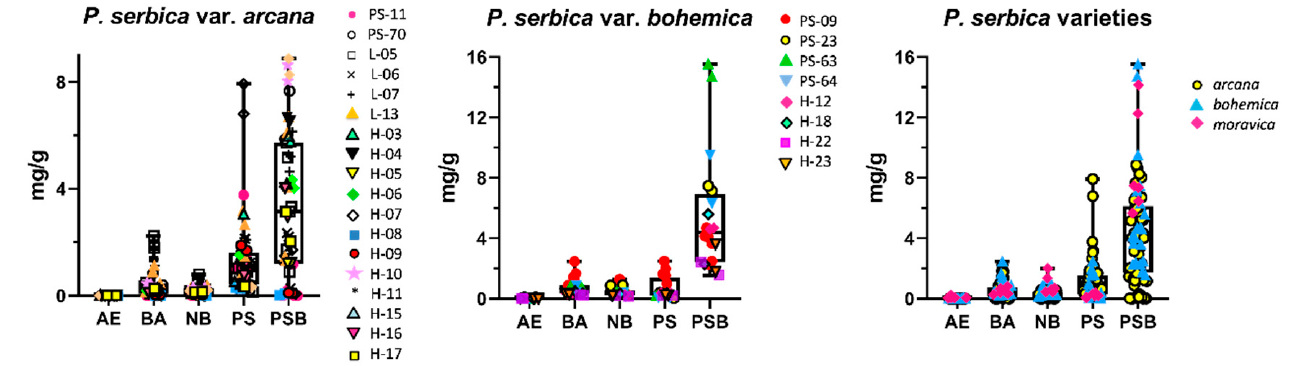
Figure 5. Tryptamine concentrations (mg/g in dry mass) in Psilocybe serbica var. bohemica , Psilocybe serbica var. arcana and the summarized data for all Psilocybe serbica varieties under study are presented in boxplots. The line in the boxplot represents the median and the whiskers signalize the minimum and maximum of the measured values.